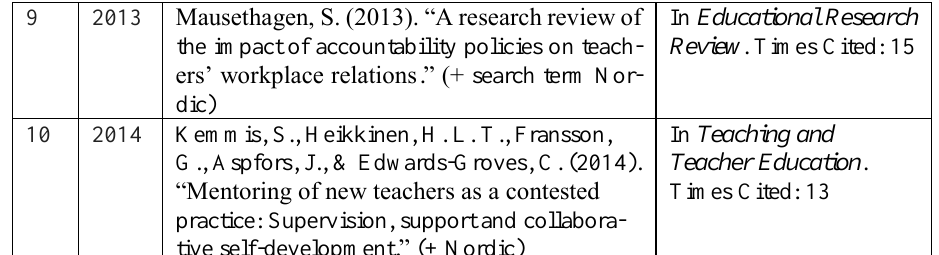
Nordic articles chosen for the